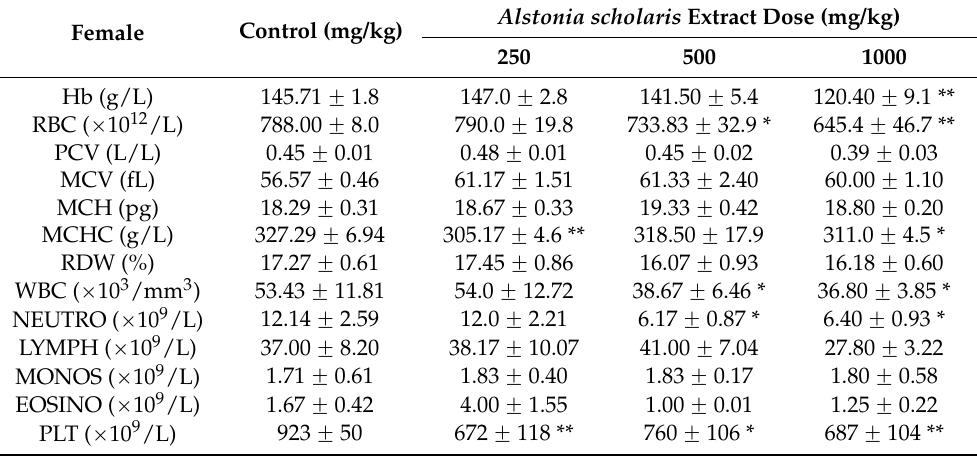
Table 9. Serum hematological values of female rats orally treated with the methanolic extract of the bark of Alstonia scholaris . Results were expressed as the mean ˘ S.E.M., n =